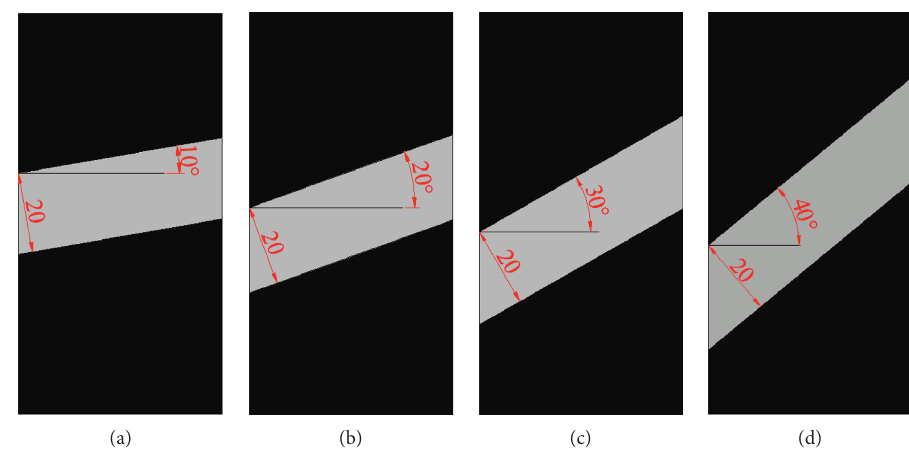
Figure 1: Composite specimens with different rock-parting dip angles ( θ ). (a) 10 ° . (b) 20 ° . (c) 30 ° . (d) 40 ° .